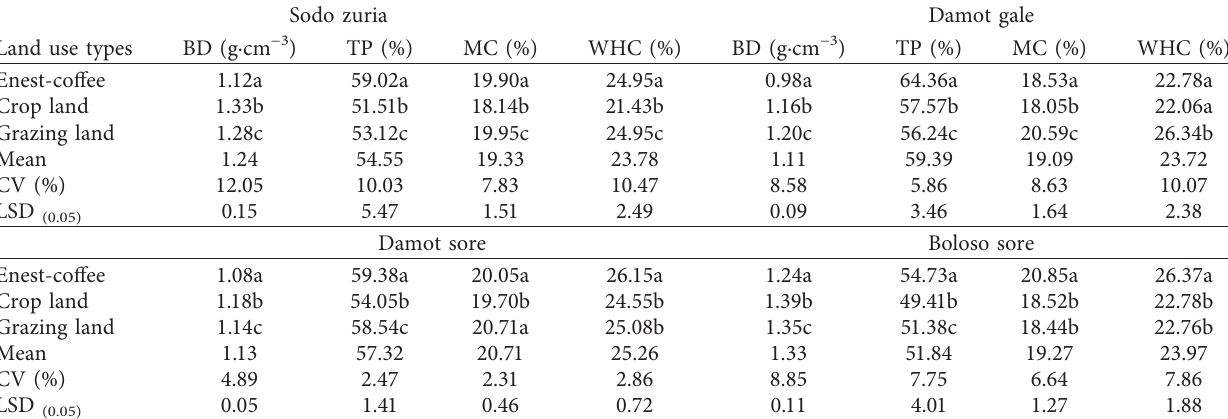
Table 2: Mean valves of ( n � 108) some selected physical properties of different locations and land use types of study